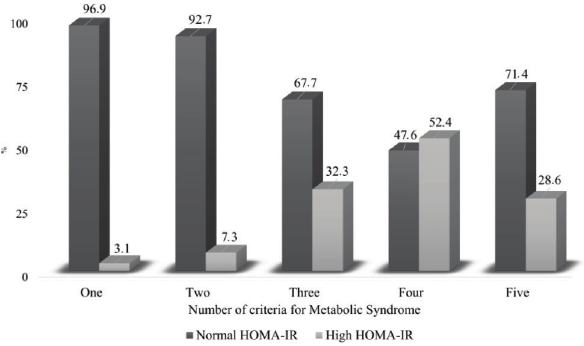
Figure 1 - The presence of IR (HOMA-IR) according to the number of components of metabolic syndrome present in bank employ- ees,